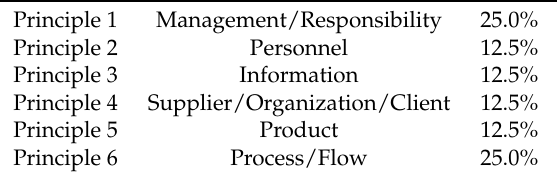
Table 2. Principles contained in SAE J4000 and the relative weighting assigned to